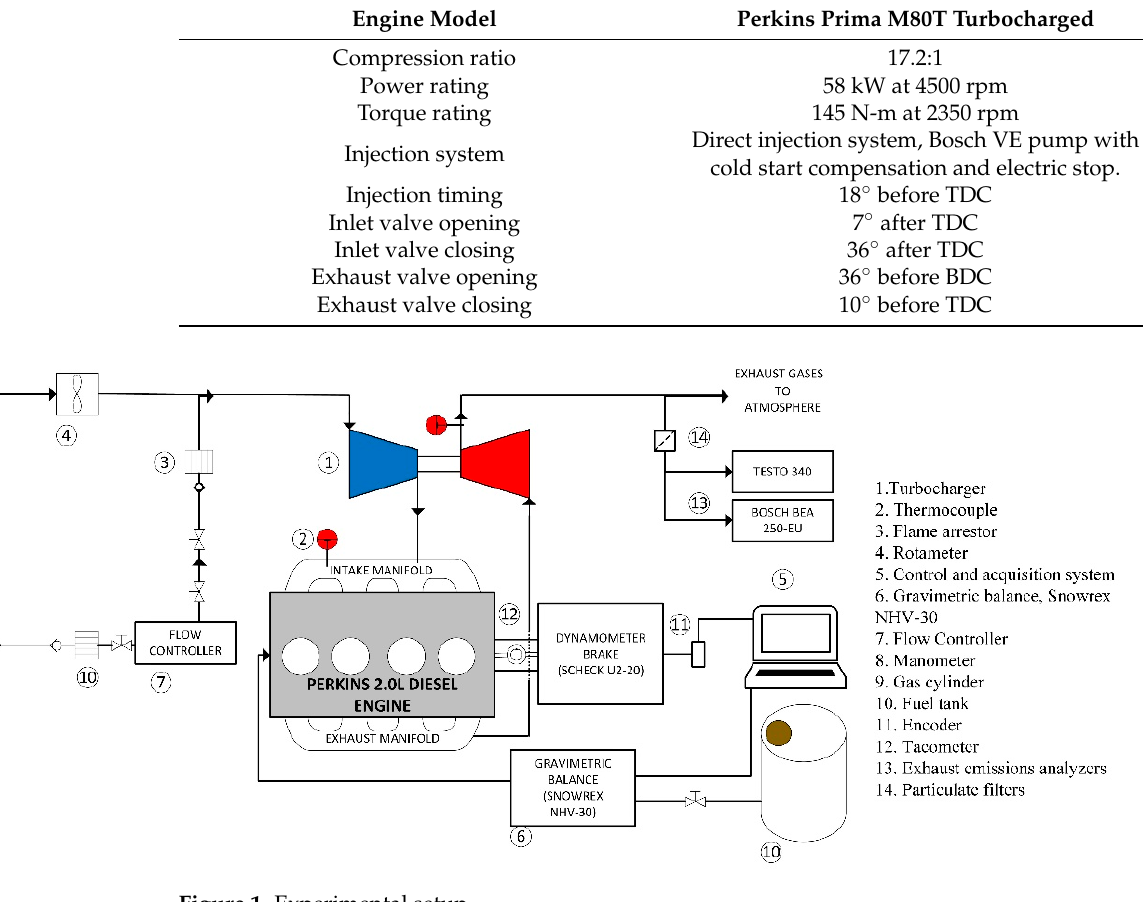
Figure 1. Experimental setup.